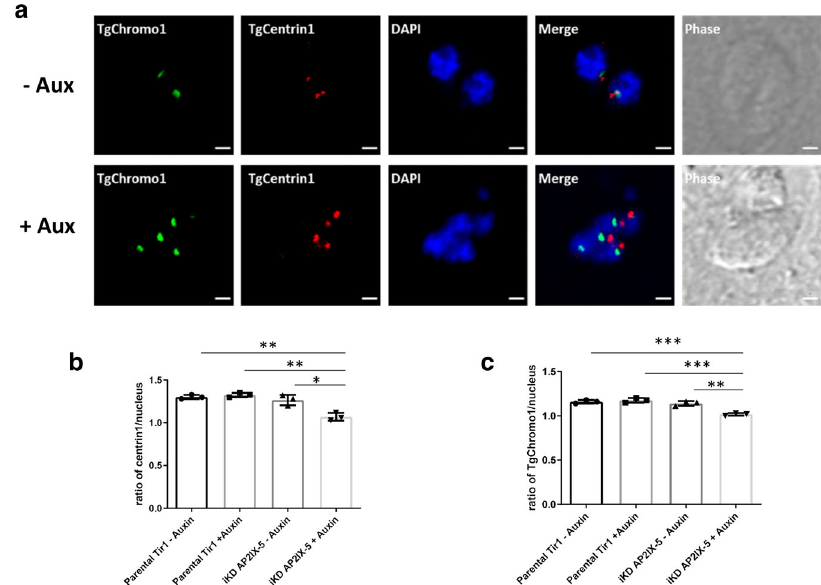
Fig. 3 Centrosome division is mostly unaffected in the absence of TgAP2IX-5. a Confocal imaging of iKD TgAP2IX-5 labelled with TgChromo1 and TgCentrin1. TgChromo1 is indicated in green. TgCentrin1 is indicated in red. DAPI was used to stain the nucleus. Scale bar is indicated at the lower right side of each image. Occasional disconnection between centromere and outer-centrosome was observed but does not represent the majority of cases. b Bar graph representing TgCentrin1: nucleus ratio using the parental and iKD TgAP2IX-5 strains in the absence and presence of auxin treatment for 6 h. A Student ’ s t -test was performed, two-tailed p -values: ** p = 0.0015 (iKD TgAP2IX-5 + auxin compared to Parental Tir1 -auxin), ** p = 0.001 (iKD TgAP2IX-5 + auxin compared to Parental Tir1 + auxin), ** p = 0.0112 (iKD TgAP2IX-5 + auxin compared to iKD TgAP2IX-5 − auxin); mean ± s.d. ( n = 3 independent experiments). c Bar graph representing chromo1: nucleus ratio using the parental and iKD TgAP2IX-5 strains in the absence and presence of auxin treatment for 6 h; A Student ’ s t -test was performed, two-tailed p -values: *** p = 0.0006 (iKD TgAP2IX-5 + auxin compared to Parental Tir1 − auxin), *** p = 0.0007 (iKD TgAP2IX-5 + auxin compared to Parental Tir1 + auxin), ** p = 0.0022 (iKD TgAP2IX-5 + auxin compared to iKD TgAP2IX-5 − auxin); mean ± s.d. ( n = 3 independent